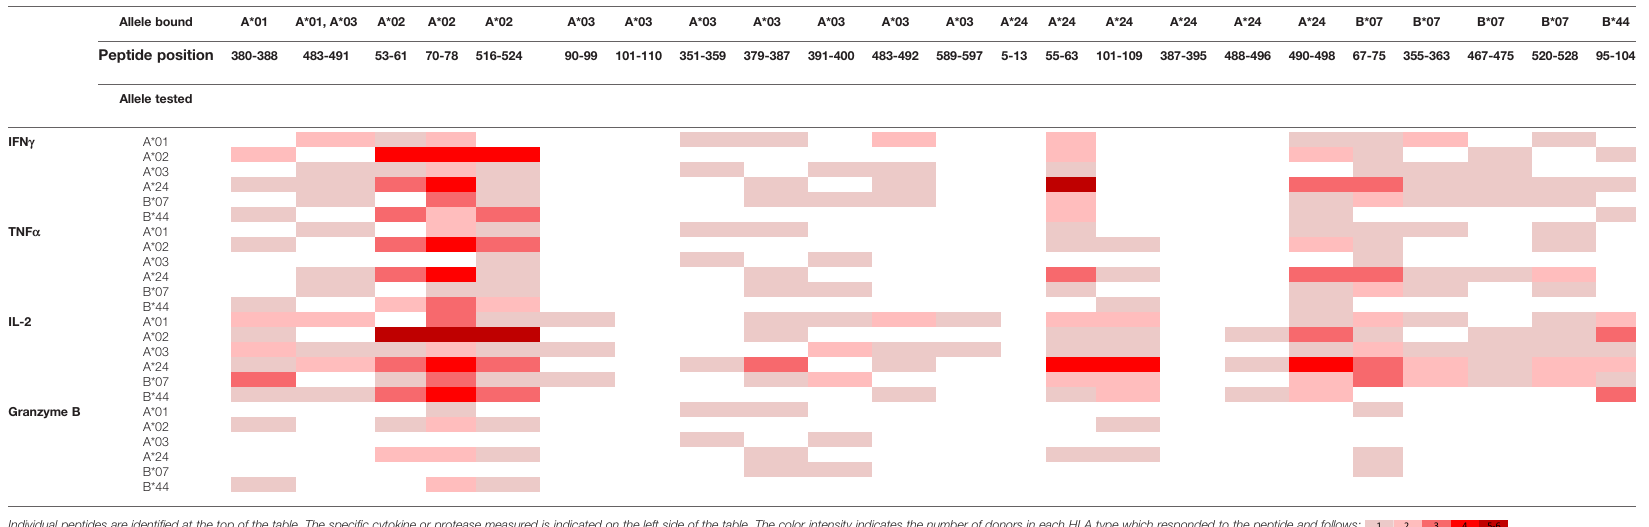
Individual peptidesare identi fi ed at the topofthe table. The speci fi ccytokineor protease measured is indicatedon the left side ofthe table. The color intensityindicates the number ofdonors in each HLA type which respondedto the peptide andfollows: 1 2 3 4 5-6 .